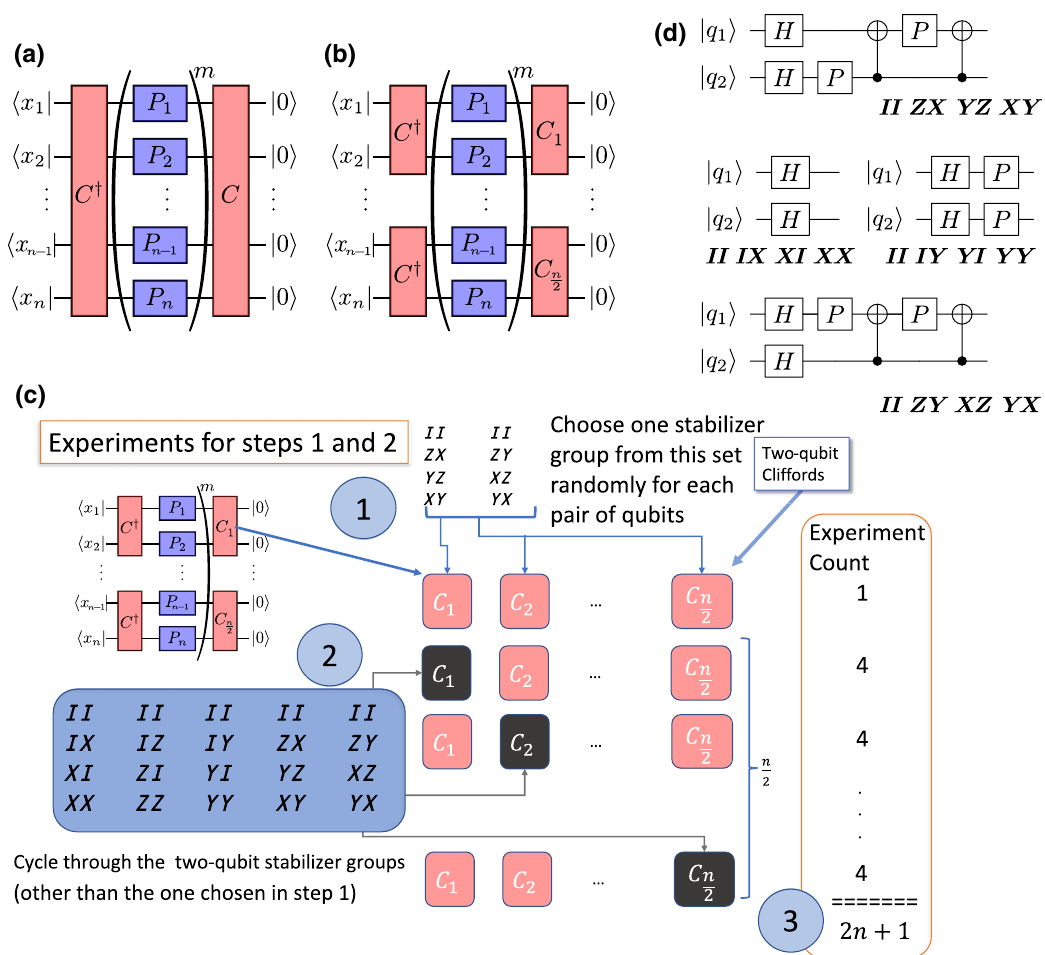
FIG. 3. (a) The type of circuit described in Ref. [37] that allows the recovery of 2 n eigenvalues of the averaged noise channel of the device. The random Pauli gates (blue) are used to twirl the channel and by averaging over a number of random choices of Pauli gates, the noise channel in the device is transformed into a Pauli channel. In a similar way to randomized benchmarking, by repeating the twirl for a certain number of Pauli gates ( m ) and then returning the system into the computation basis by choosing the Pauli inverting the twirl, a decay curve will be induced and this can then be fit to determine the eigenvalues independently of state preparation and measurement errors. The single n -qubit Clifford (and its inverse at the end) determines which of the 4 n Paulis are sampled and an appropriate Clifford can be used to select any n -qubit stabilizer set. (b) A further modification of the circuit, where instead of using a generic n -qubit Clifford only two-qubit Cliffords are used. (Where the device has an odd-number of qubits, a single Clifford can be used on one of the qubits.) As discussed in the text, for each chosen value of m the circuit is repeated for multiple sequences with different randomly chosen Paulis, but for fixed Cliffords. Collectively each of the runs for multiple choices of Paulis carried out over several different lengths of m are defined as an experiment . (c) How, once an experiment has been chosen in step 1 of the procedure, further experiments are created in order to determine the offsets required to identify the Pauli (see text). As shown in step 2, each of the two qubit Cliffords needs to be cycled sequentially through the four other two-qubit stabilizer groups (i.e., the four that are different from the initial choice). This means that for each sequence in step 1, a further 2 n experiment needs to be performed, leading to 2 n + 1 experiments per chosen stabilizer group. For the second group an offset of one qubit should be chosen, meaning the local stabilizer groups now span different qubit pairs. Simple Pauli twirls can be carried out on any odd or isolated qubits. (d) Some example subcircuits required to perform the transform into the local stabilizer group listed in (c)—step 2. The inverse gate will be of a similar